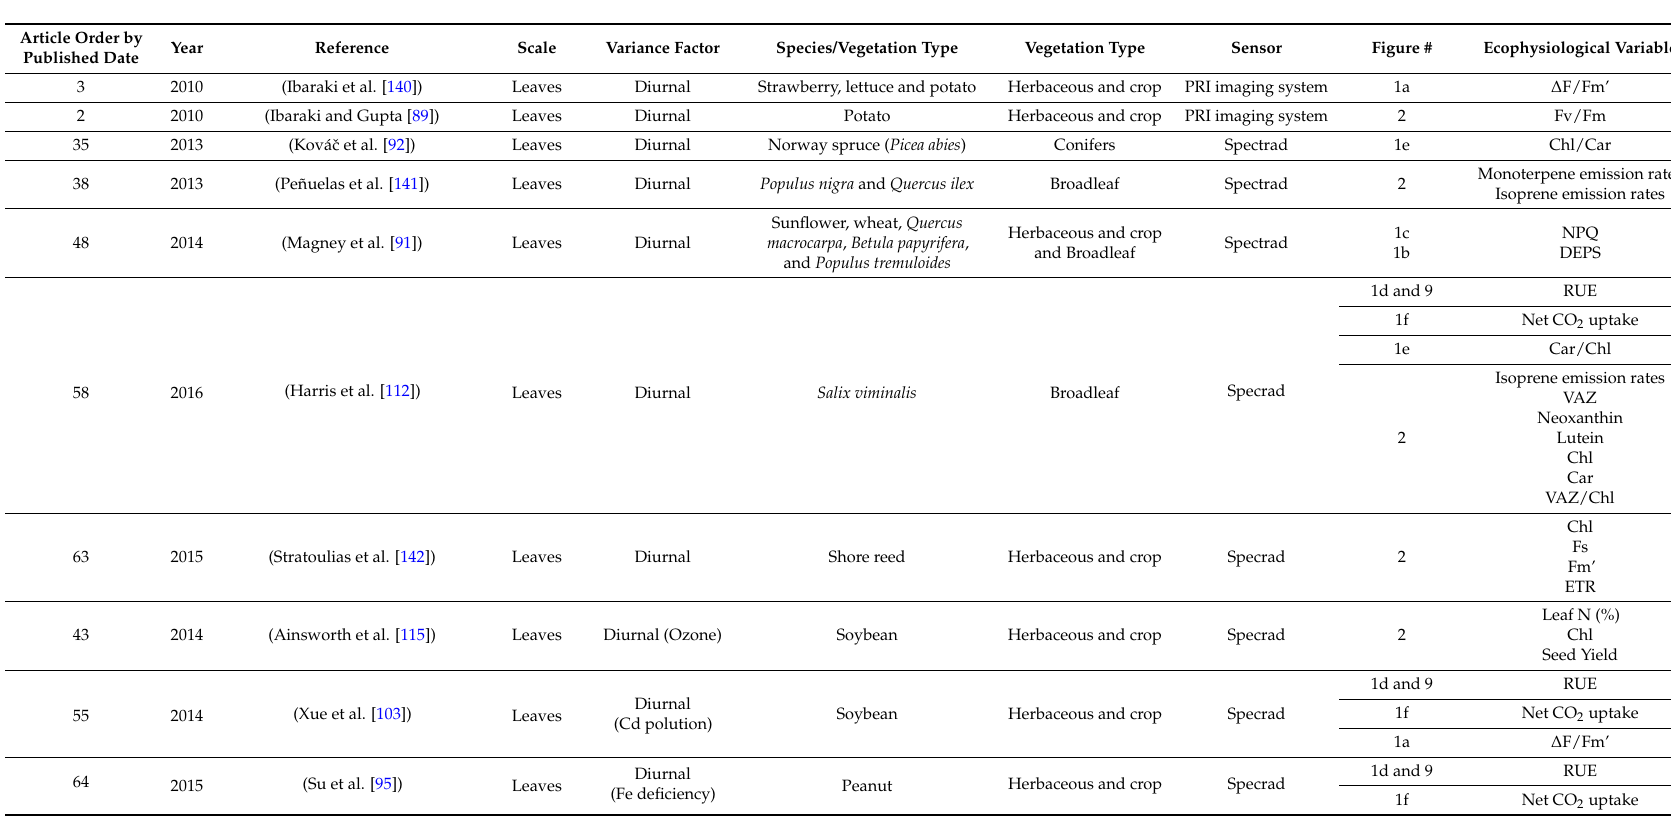
Table 1. List of published studies (2010–2015) linking photochemical reflectance index (PRI) with ecophysiological variables. Specrad, spectroradiometer. Abbreviations for the ecophysiological variables: RWC, relative water content; gS, stomatal conductance; RUE, radiation-use efficiency; net CO 2 uptake, net photosynthetic rate, gross primary productivity or light-saturated photosynthesis; EPS or DEPS, epoxidation or de-epoxidation state of the xanthophylls; Fv/Fm, maximum photochemical efficiency of PSII; ∆ F/Fm’, effective quantum yield, actual photochemical efficiency or photochemical efficiency of photosystem II ( Φ PSII); Fs, steady-state fluorescence; NPQ, non-photochemical quenching; Chl/Car or Car/Chl, chlorophyll/carotenoid or carotenoid/chlorophyll ratio; VAZ, xanthophyll-cycle pigment pools; V, violaxanthin; A, antheraxanthin; Z, zeaxanthin; L, lutein; qN, non-photochemical quenching; PPFD, photosynthetic photon flux density; fAPAR, fraction of absorbed photosynthetically active radiation; fIPARg, fraction of photosynthetically active radiation intercepted by vegetation; α s , canopy shadow fraction; Tl-Tair, leaf minus air temperature; Tc-Ta, crown minus air